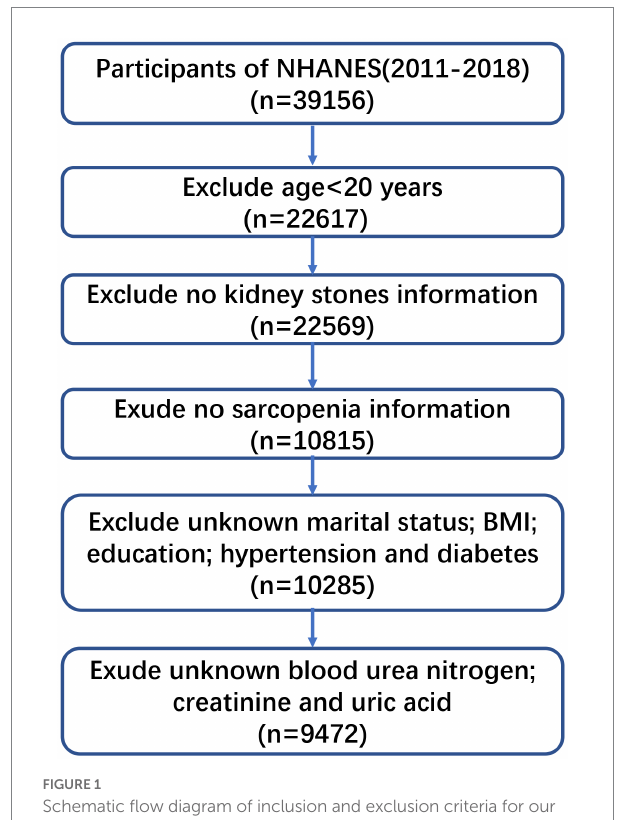
FIGURE 1 Schematic flow diagram of inclusion and exclusion criteria for our study